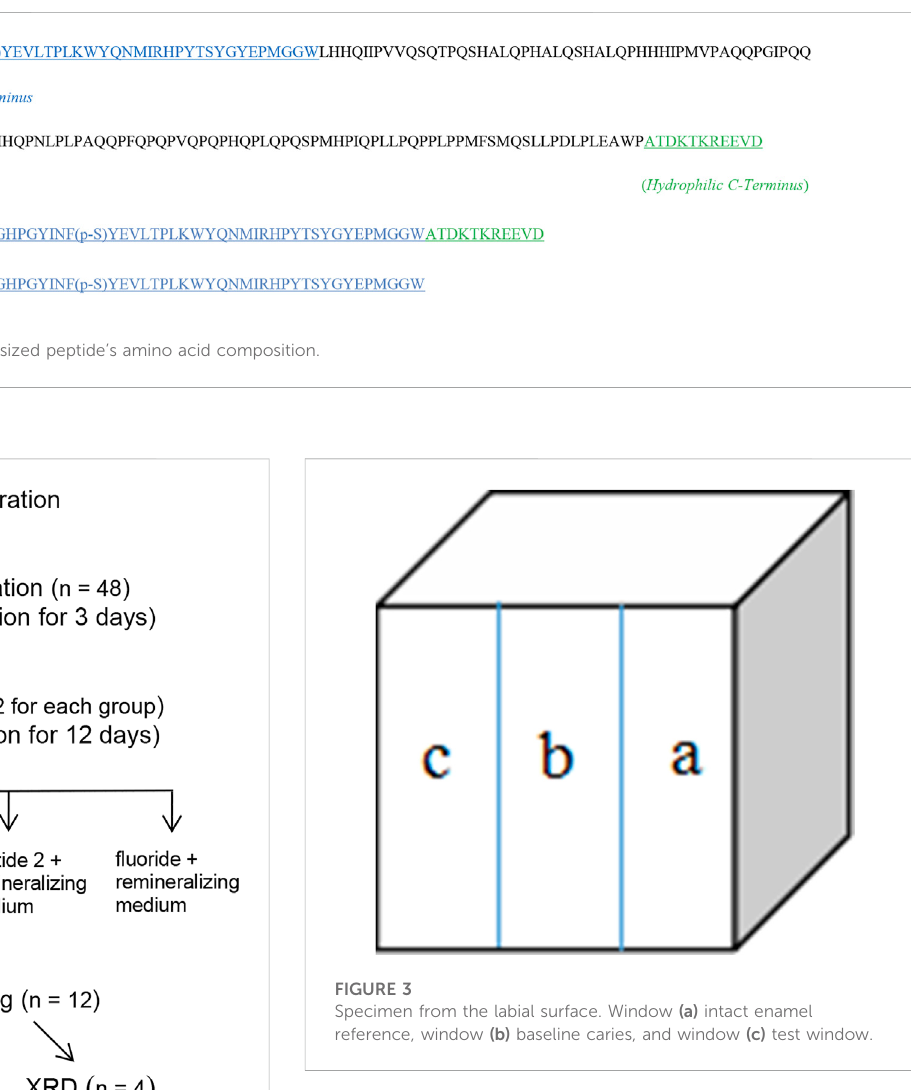
FIGURE 2 Flowchart of the study.